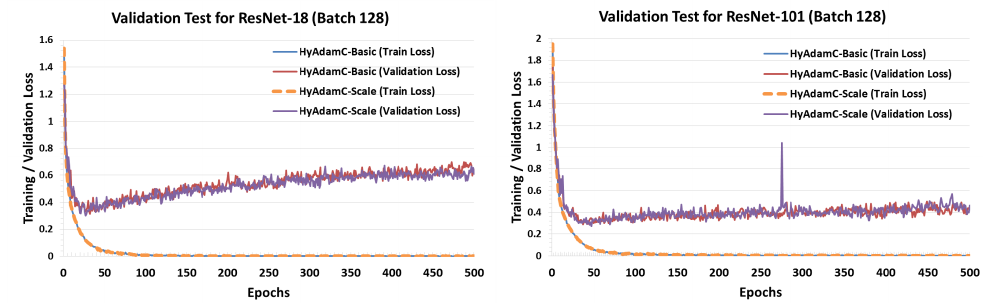
Figure 27. The training and validation loss curves of HyAdamC-Basic and HyAdamC-Scale in ResNet. The left and right plots shows the loss curves of HyAdamC evaluated in ResNet-18 and 101, respectively.